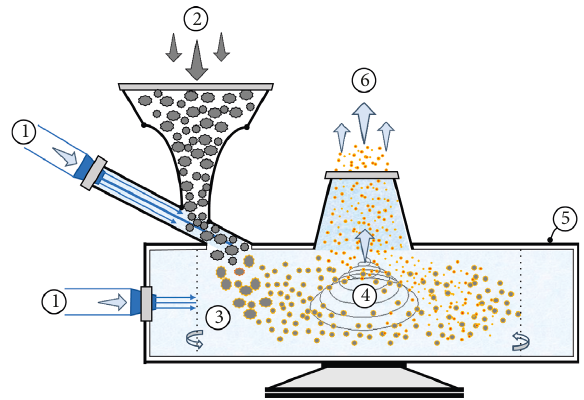
Figure 1: Schematic illustration of the air jet milling process. 1, compressed air (feeding); 2, feed funnel; 3, compressed air (mill- ing); 4, milling chamber; 5, steel structure of air jet mills; 6, mi- cronized product